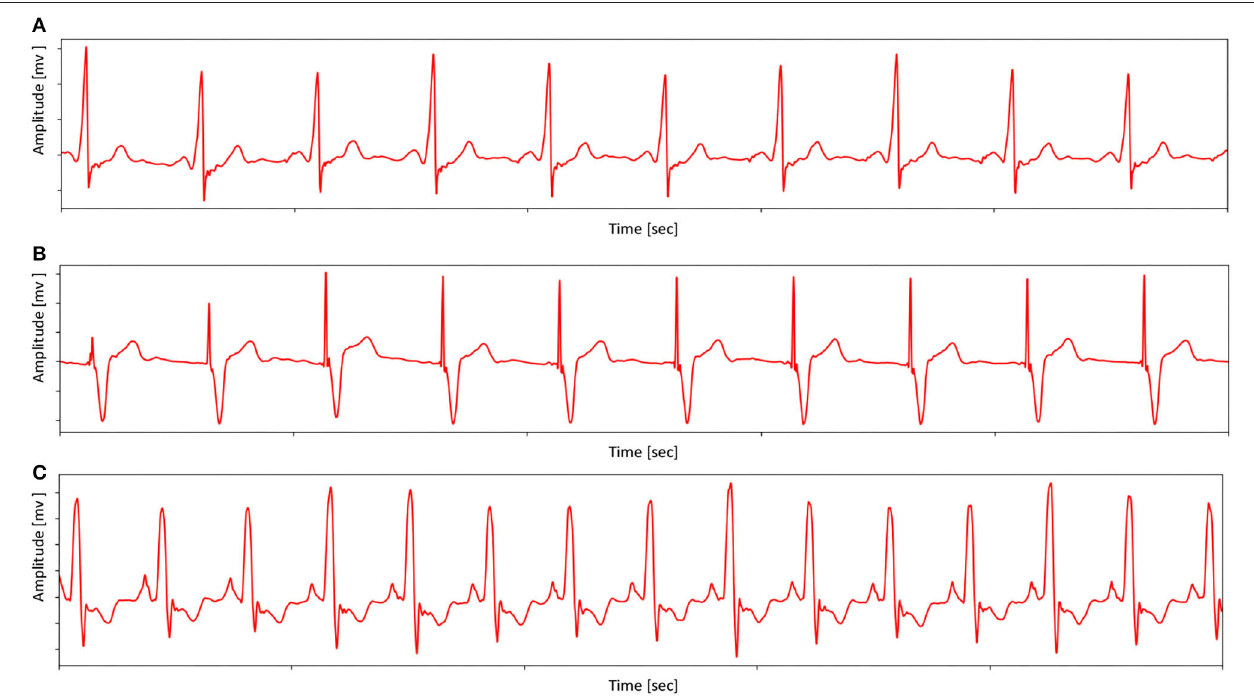
FIGURE 4 | Examples ECG (from Lead II) in pacing ECG database. (A) An example shows the morphology of the pacing ECG. (B) An example shows that the morphology of pacing ECG receives other abnormal interference. (C) An example shows that the ECG morphology of the complete left bundle branch block is similar to pacing ECG. Note that sample (A) has no obvious pacemaker nail in lead II, but the proposed MAE method can distinguish the (C) and pacing type by other lead